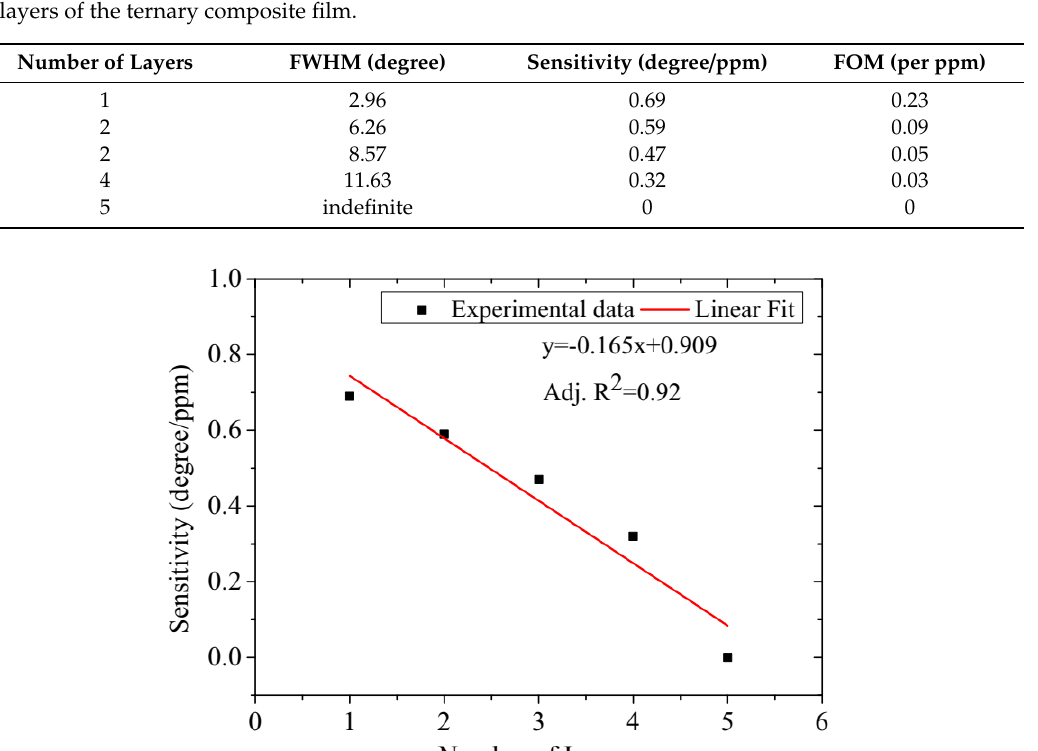
Figure 7. SPR sensor sensitivity versus the number of ternary composite